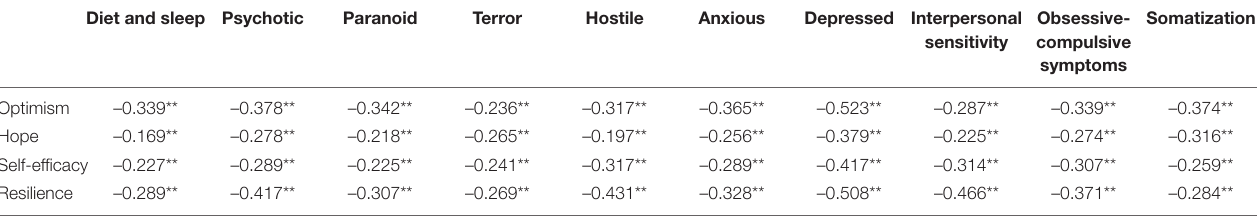
TABLE 1 | Analysis of the correlation between college students’ psychological quality education and mental health level.